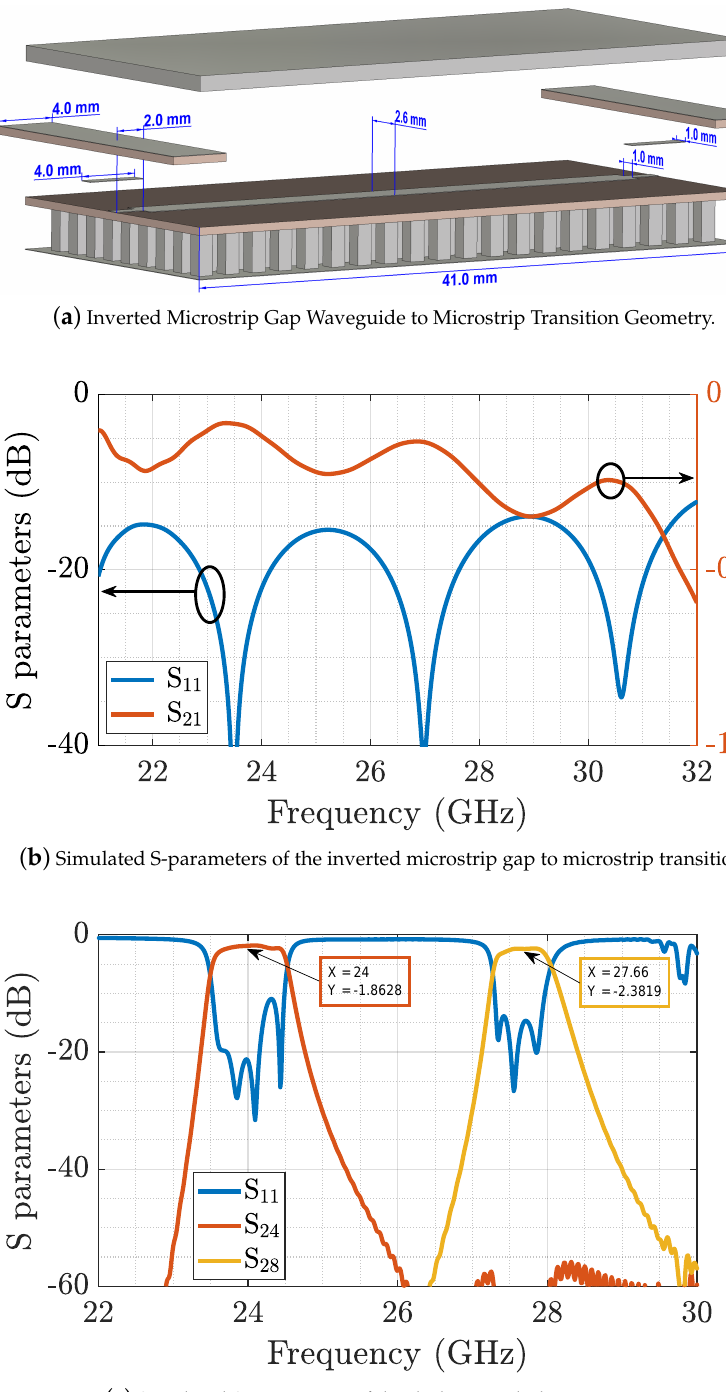
Figure 5. Microstrip to Inverted Microstrip Gap Waveguide designed transition and final diplexer design with RO4003C TM